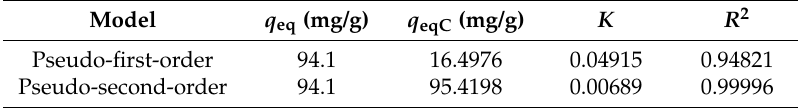
Table 2. Fitting parameters of adsorption isotherm models.